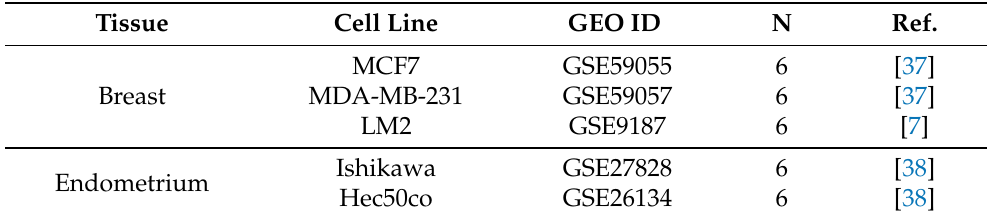
Table 1. Sources and contacts of